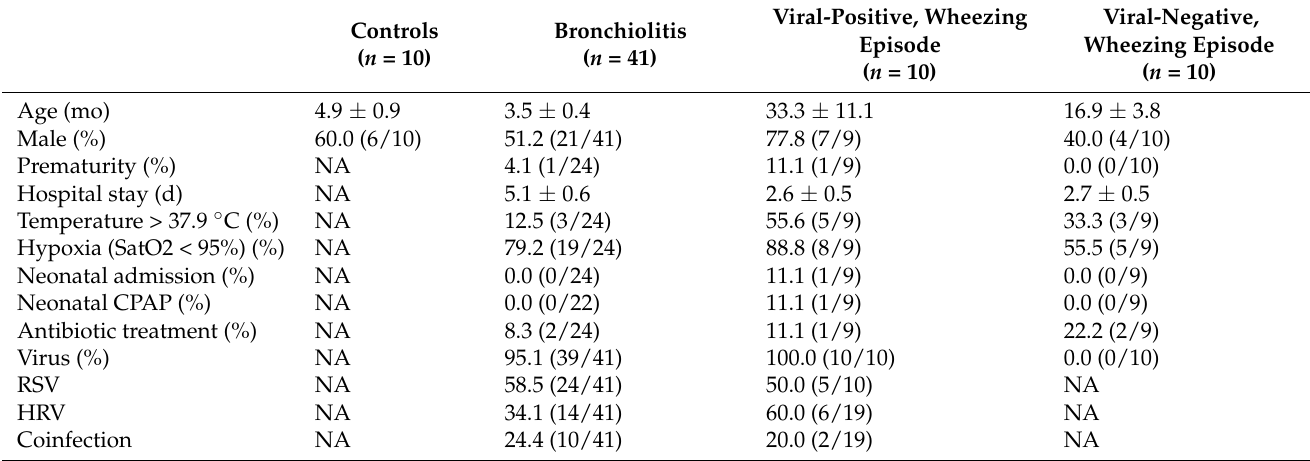
Table 1. Demographic and clinical data of study